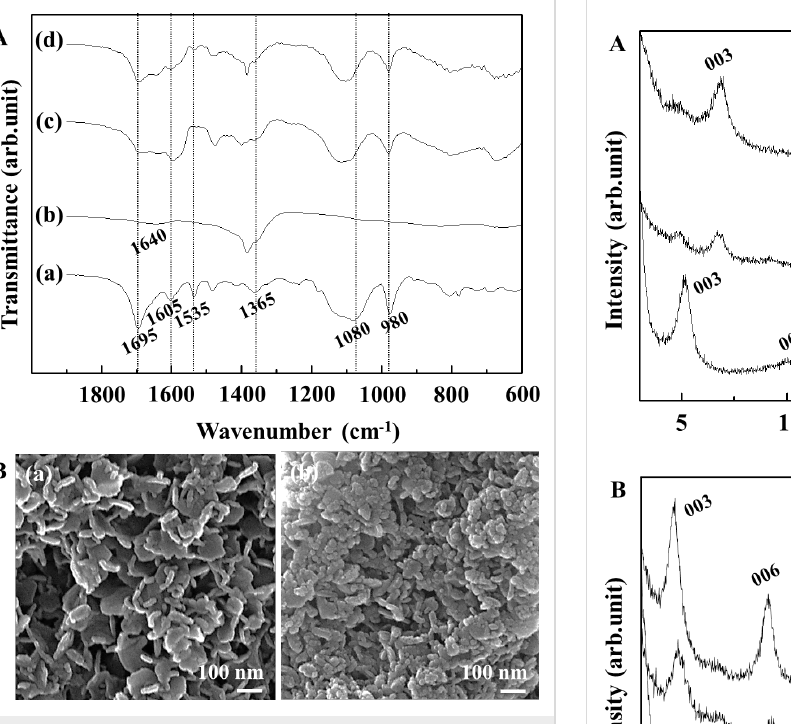
Figure 6: (a) Fourier transformed infrared (FTIR) spectra of GMP powder (line a), pristine MgAl-NO 3 -LDH (line b), GL-S (line c) and GL-R hybrid (line d). (b) Scanning electron microscopic (SEM) images of GL-S (image a) and GL-R hybrid (image b).